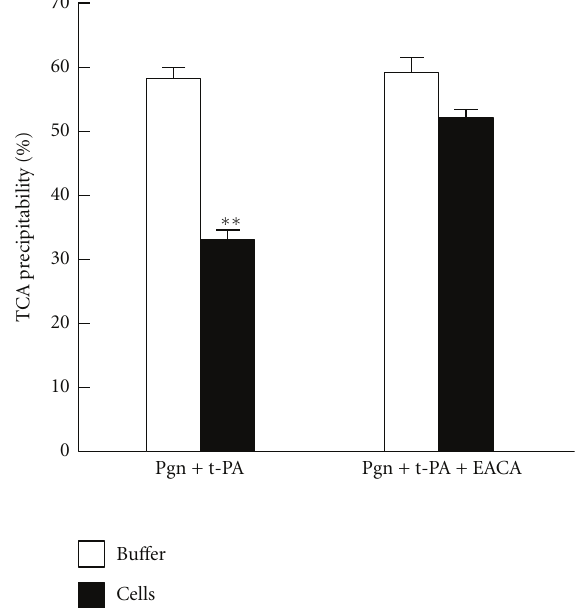
Figure 4: E ff ect of cells on cleavage of 125 I-CgA by plasmin. Either PC12 cells (filled bars) or bu ff er (open bars) was incubated with unlabeled plasminogen. Then, 125 I-CgA and t-PA were added in either the presence or the absence of EACA. The reactions were stopped by addition of aprotinin and centrifuged. The supernatants were analyzed for % TCA precipitability. Results are as mean +SEM; n = 6 for each experimental group. ∗∗ P < 0 . 001 compared to each of the experimental groups. [1].